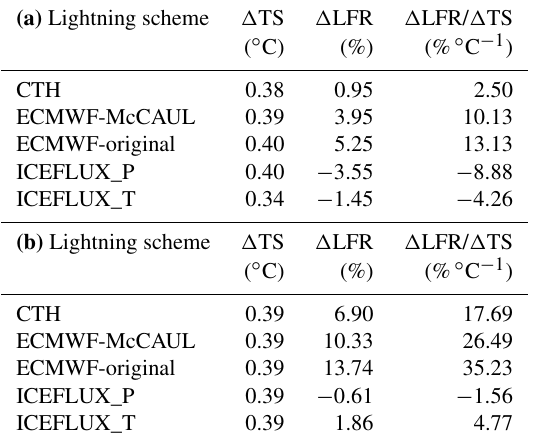
Table 4. Changes in global mean surface temperature ( (cid:49) TS), global mean lightning flash rate ( (cid:49) LFR), and the rate of change in light- ning flash rate corresponding to each degree Celsius increase in global mean surface temperature ( (cid:49) LFR/ (cid:49) TS). Panel (a) shows re- sults obtained without nudging. Panel (b) presents results obtained with nudging. Changes were obtained by calculating the difference between the rightmost and leftmost points of the approximating curve for the 2001–2020 time series